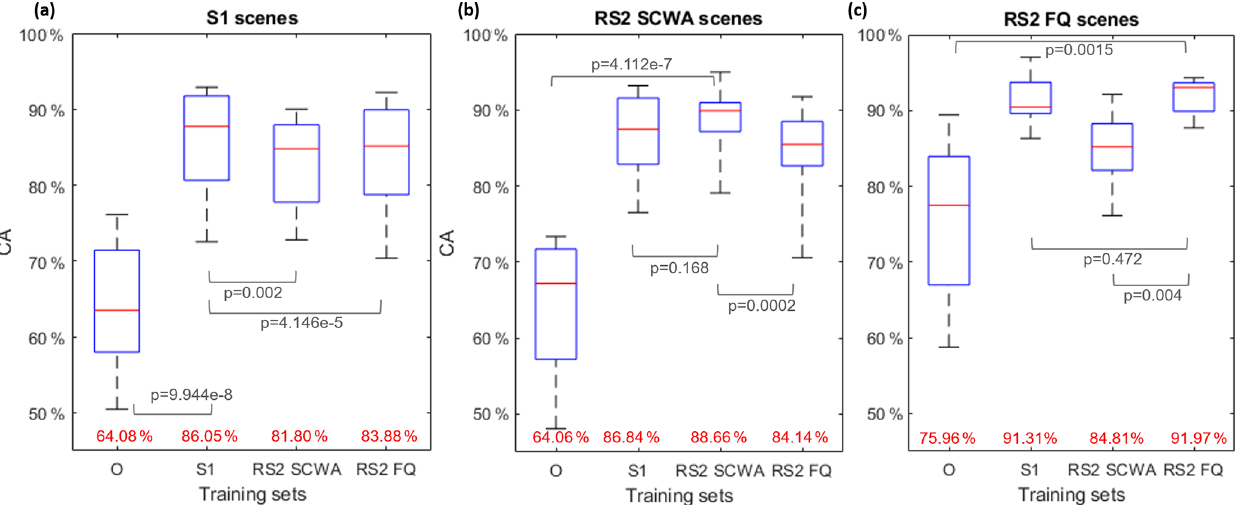
Figure 5. CAs for S1, RS2 SCWA and RS2 FQ scenes using the original and retrained GIA classifier. O: training for the original GIA classifier; S1, RS2 SCWA, RS2 FQ: regional S1, RS2 SCWA and RS2 FQ training, respectively. Mean CAs are displayed in red below the box plots. P values of the difference in mean CAs are also